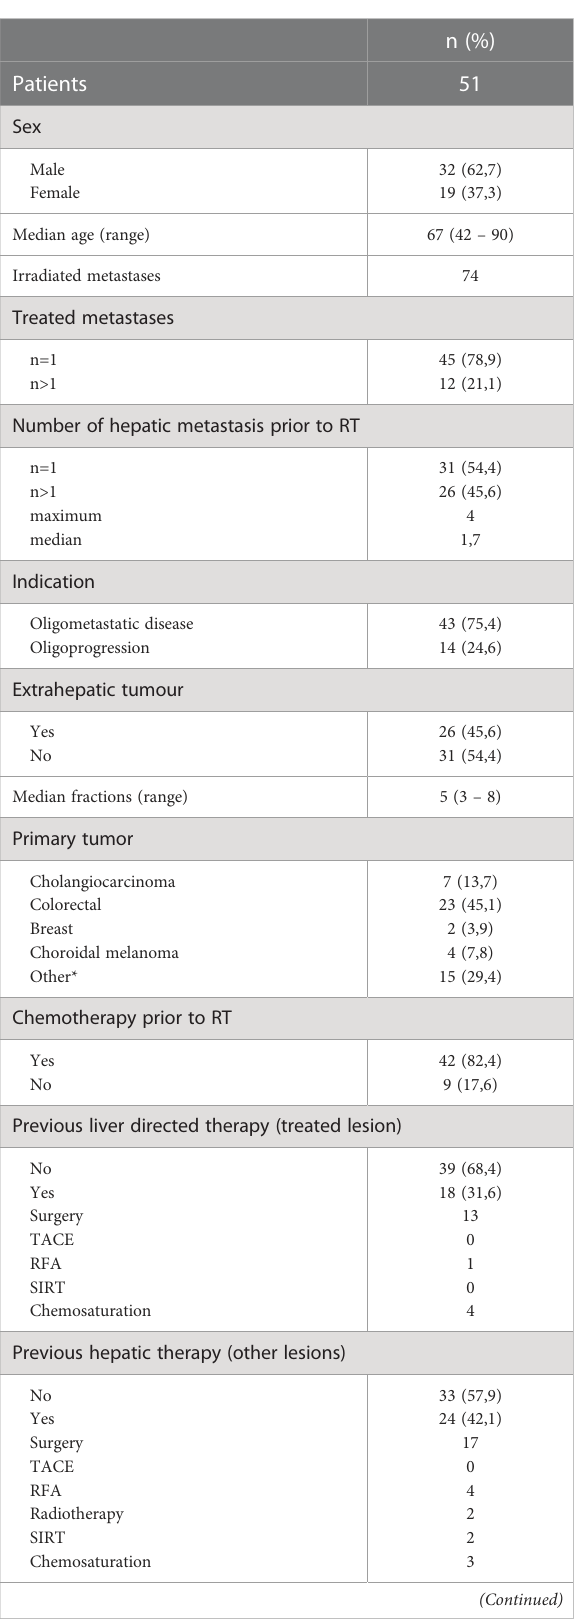
TABLE 1 Patient and treatment